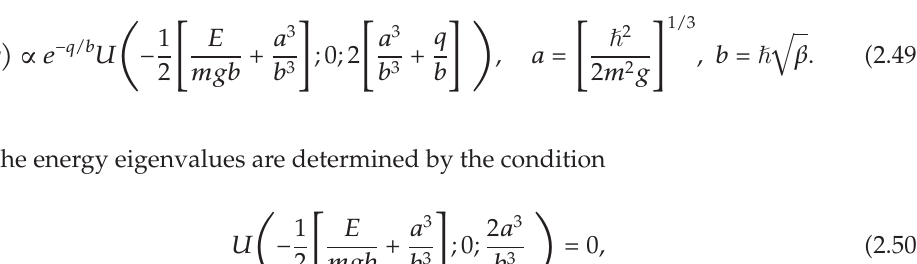
are the zeroes of Ai (cid:5) z (cid:6) . The solution to the β / (cid:4) 0 case is given in terms of the confluent hyper- geometric function of the second kind (cid:2) 83–85